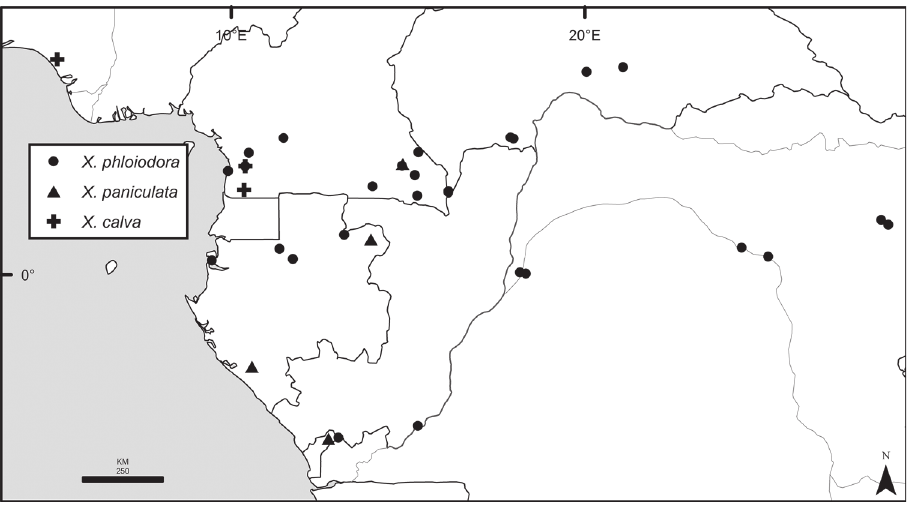
Figure 36. Distributions of Xylopia phloiodora , X. paniculata , and X. calva . Bolder lines represent country borders, fainter lines lakes and major